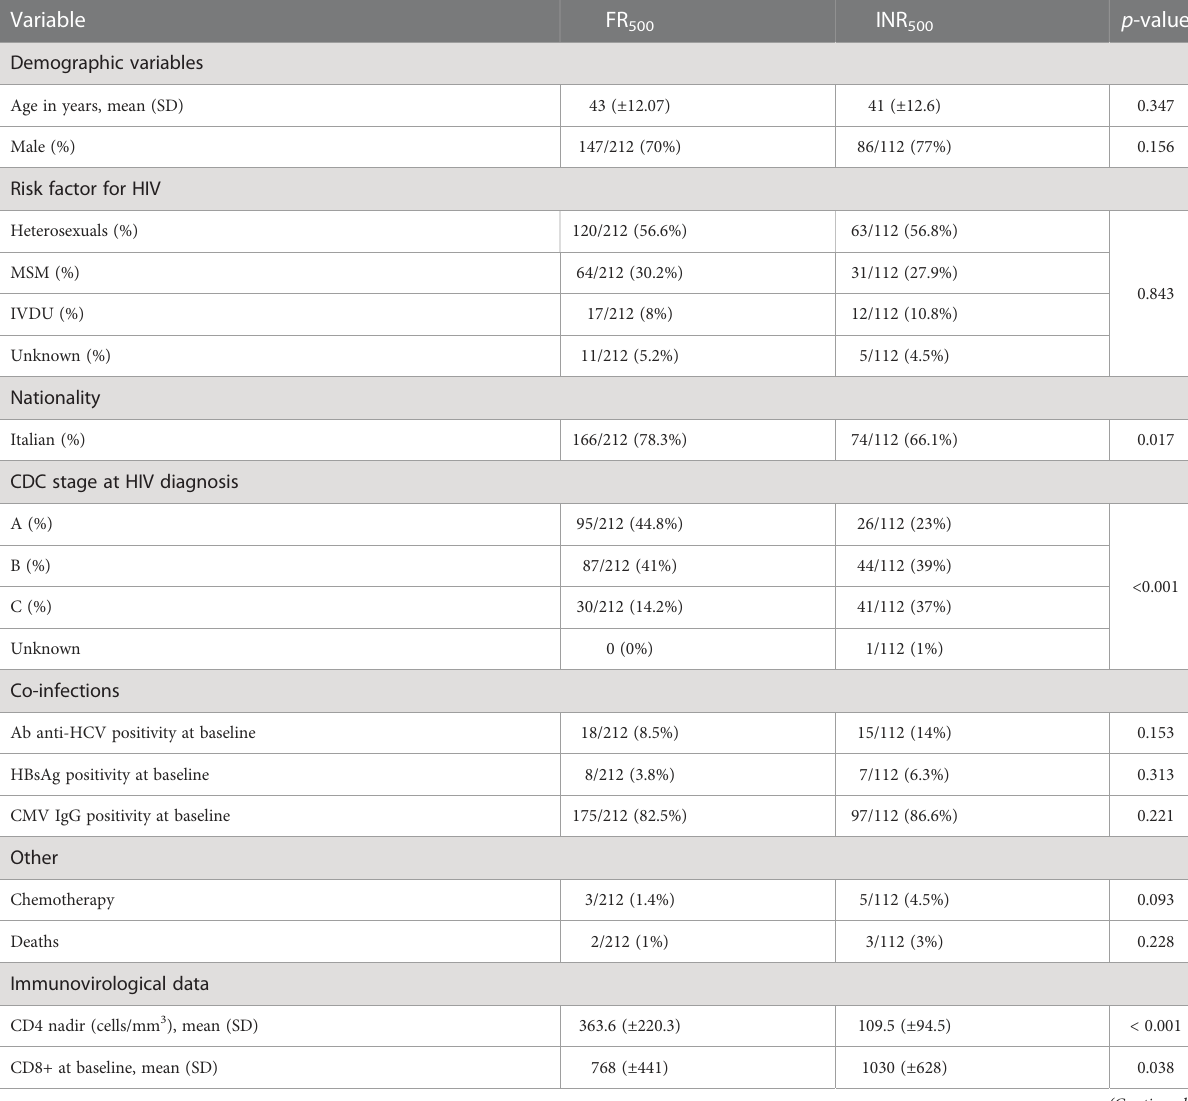
TABLE 3 Comparison of clinical and demographic characteristics of INR 500 and full responders